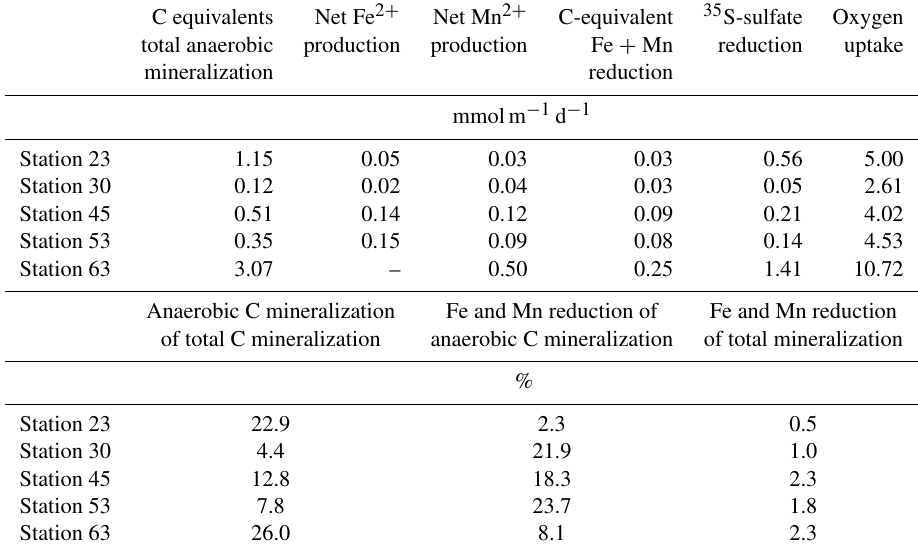
Table 3. Anaerobic rates of carbon mineralization by manganese, iron, and sulfate